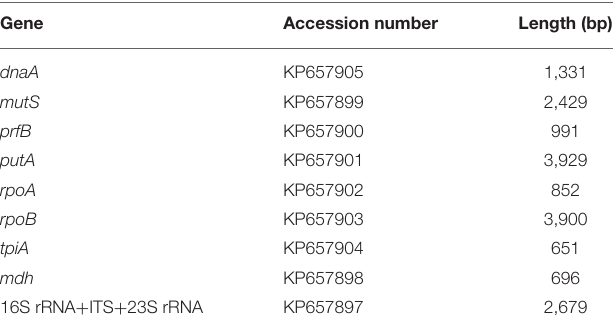
TABLE 2 | The GenBank accession number and final length of the sequenced genes from STIR-GUS-F2f7.